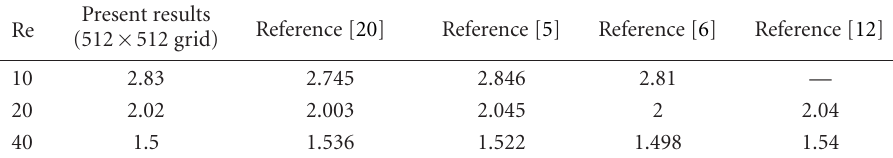
Table 4 . 1 . Verification of our second-order accurate results converged to (cid:1) < 10 − 7 with the available literature values for the case of flow with zero magnetic field.